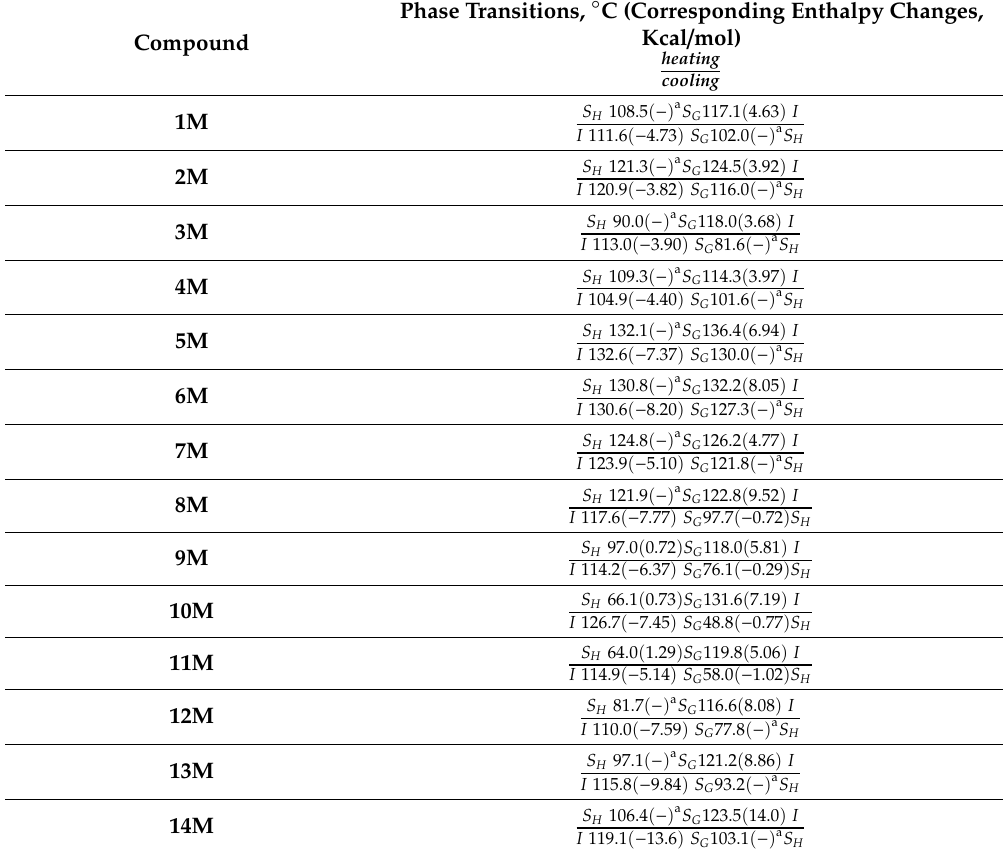
Table 1. Phase transition temperature and thermodynamic parameters of monomers 1M ~ 14M . Phase Transitions, ◦ C (Corresponding Enthalpy Changes, Compound